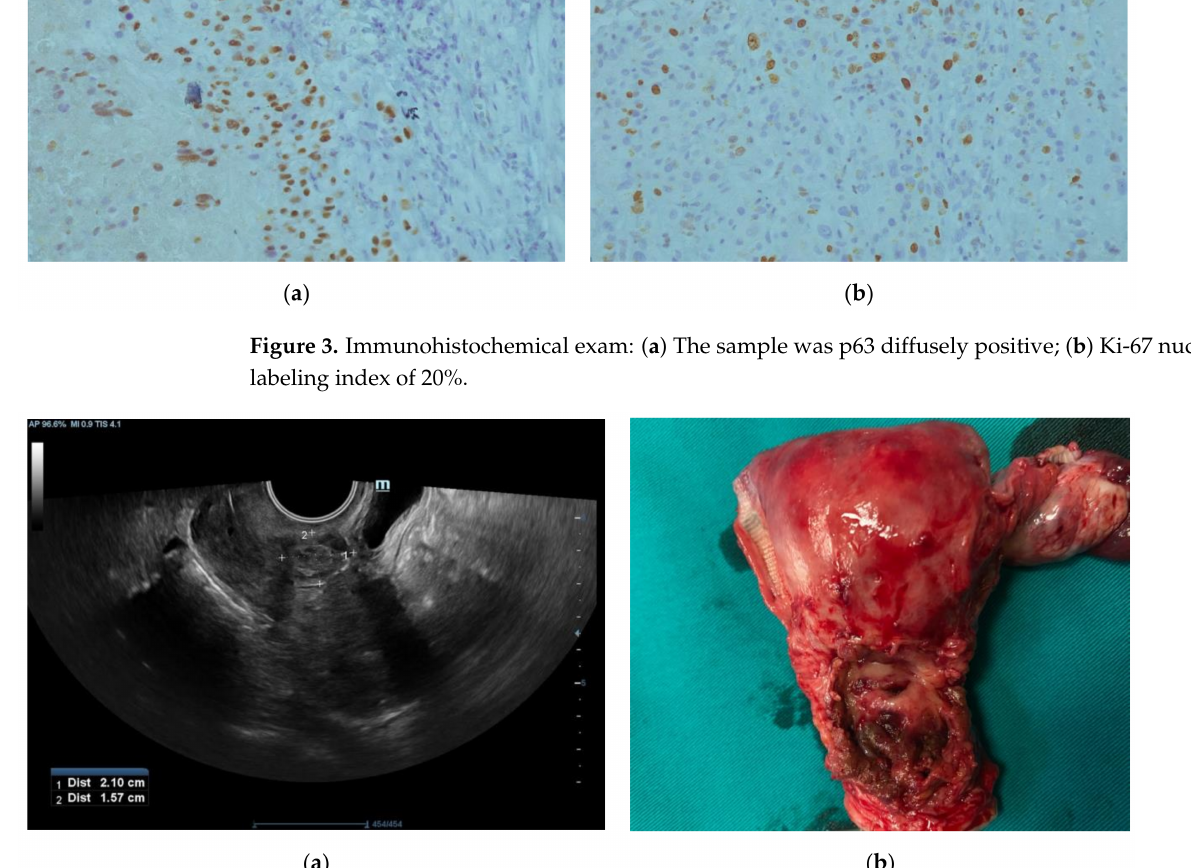
Figure 4. ( a ) Ultrasonographic exam revealing tumefaction of sharp borders to the surrounding tissue, with hypoechogenic halo; ( b ) a specimen of the uterus after the hysterectomy with the dehiscence in the region of previous Caesrean